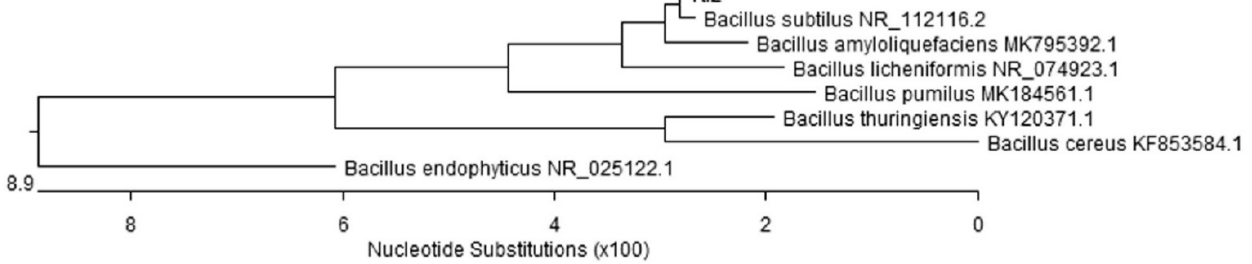
Figure 1. Phylogenetic tree based on the 16S rRNA gene sequences from Bacillus subtilis Ttl2 and other Bacillus spp.